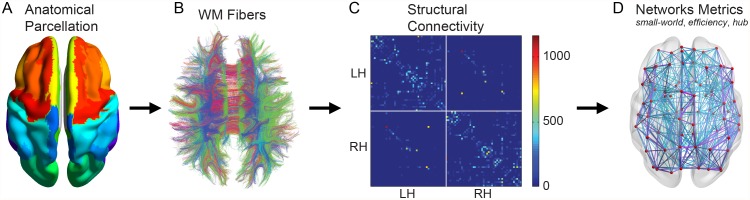
Schematic overview of the formation of the individual structural brain network.(A) Individual T1 images were used for parcellation of the cortex into 90 distinct brain regions through Automatic Anatomical Labeling (AAL) template, which form the nodes of the structural brain networks. (B) White matter fiber reconstruction in the whole cerebral cortex was performed using the fiber assignment by continuous tracking (FACT) algorithm. (C) The weighted structural brain network of each subject was created by computing the fiber numbers that connected each pair of brain regions. (D) The topological organization of the resulting individual structural brain networks was examined using graph theoretical measures.